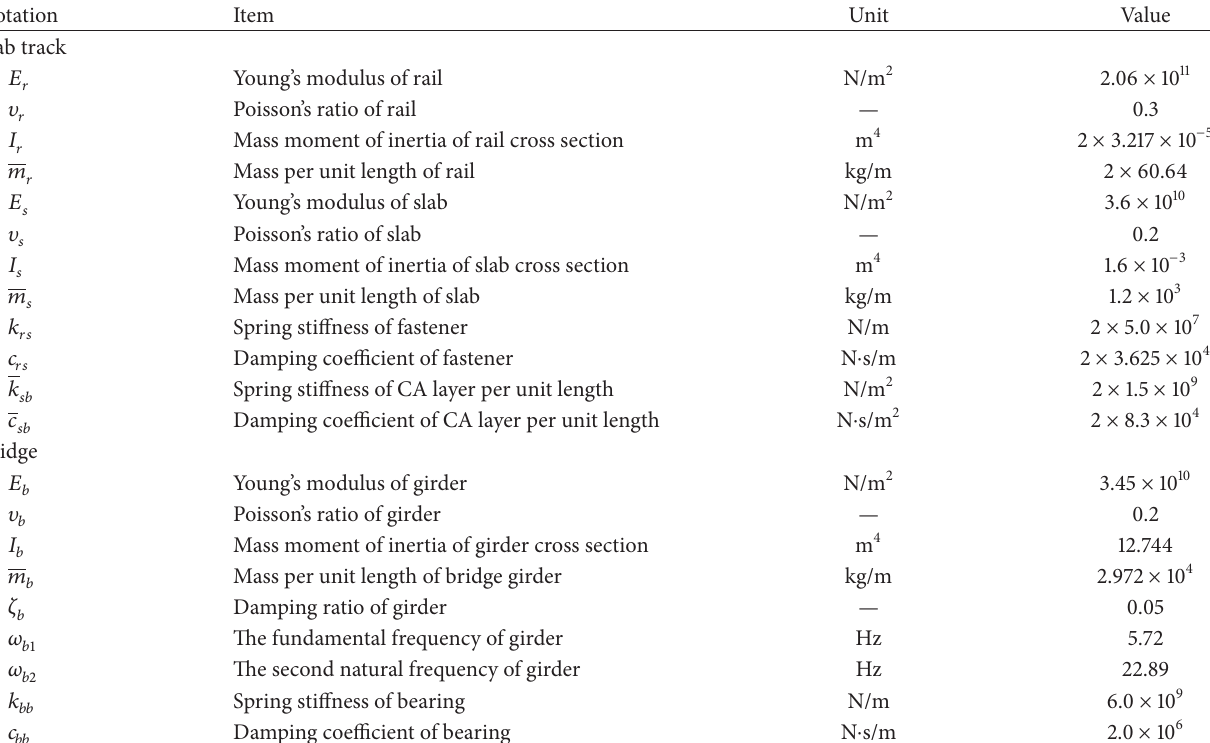
Figure 2: Flowchart for the vertical random vibration analysis of train-slab track-bridge interaction system. Table 2: Parameters for slab track and